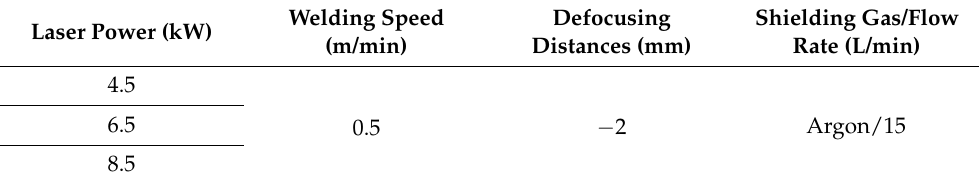
Table 2. Process parameter of laser welding for joining 2205 duplex stainless